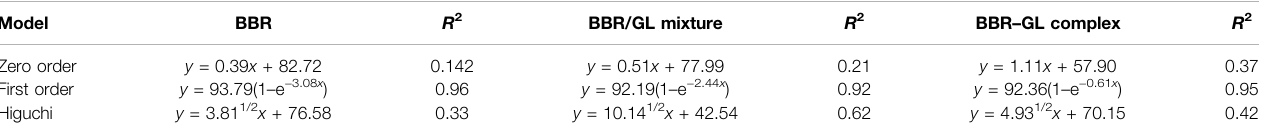
The in vitro drug release data of formulations were fi tted in three different kinetic models ( Table 1 ), that is, zero-order, fi rst- order, and Higuchi models. The in vitro drug release from BBR,